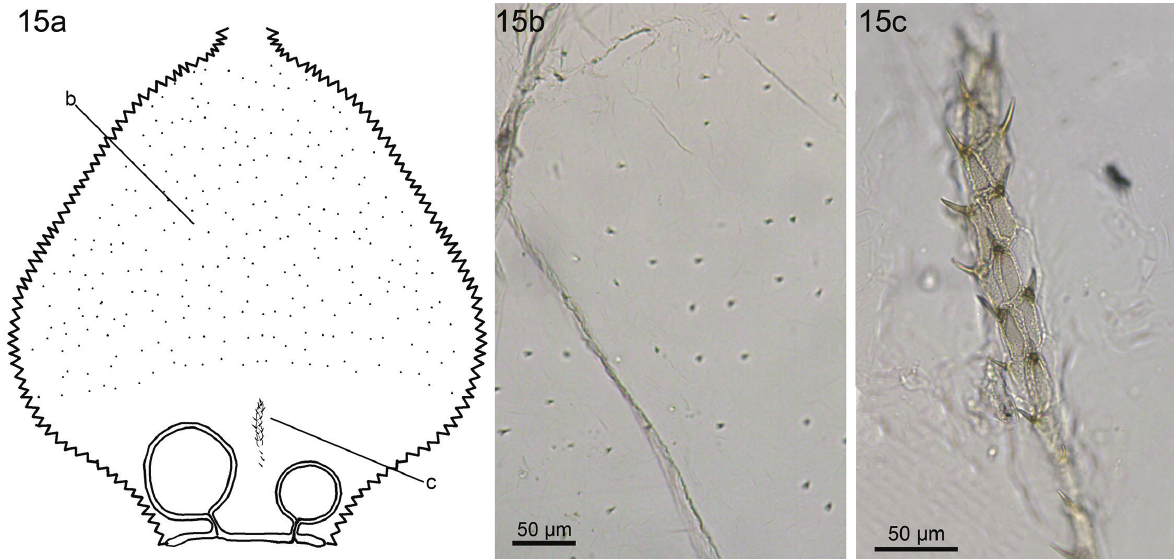
Figure 15. Labiotermes orthocephalus . (a) Schematic drawing of P1 showing arrangement of spines. (b, c) Photomicrographs: (b) Detail of the sparse short spines in the distal portion; (c) Detail of central ridge structure.